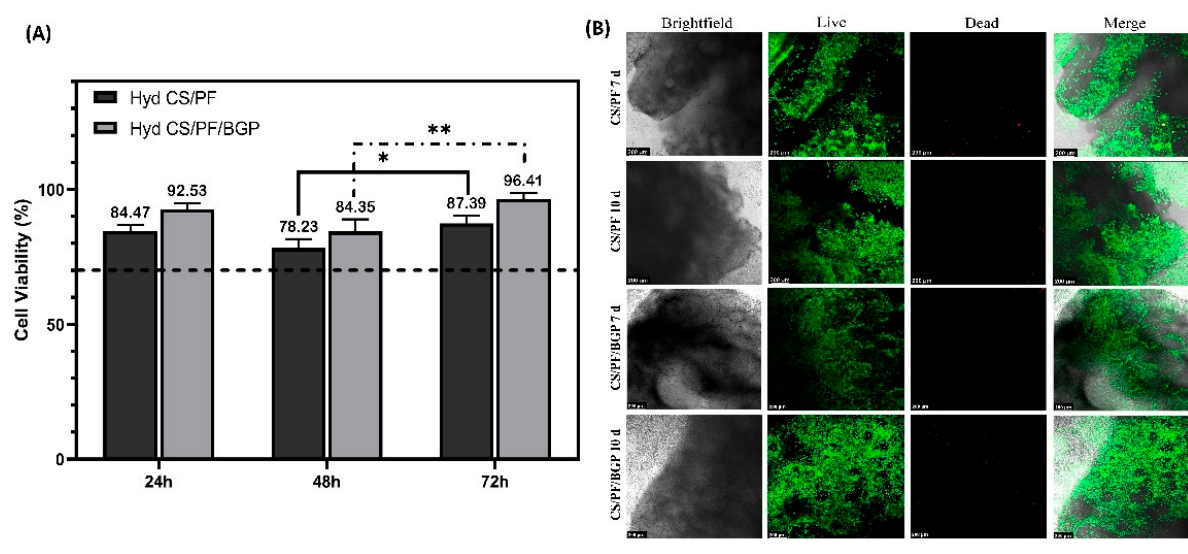
Figure 3. Viability assay and morphology of cells grown on hydrogels. ( A ) Cell viability of C28/I2 cells grown on CS/PF and CS/PF/BGP hydrogels. Values represent mean ± SD ( n = 3; two-way ANOVA, Tukey’s multiple comparisons test, * p < 0.05 and ** p < 0.01). ( B ) LIVE/DEAD ® staining of chondrocytes seeded on CS/PF and CS/PF/BGP hydrogels after 7 and 10 days in culture. Scale bar = 200 μ m.